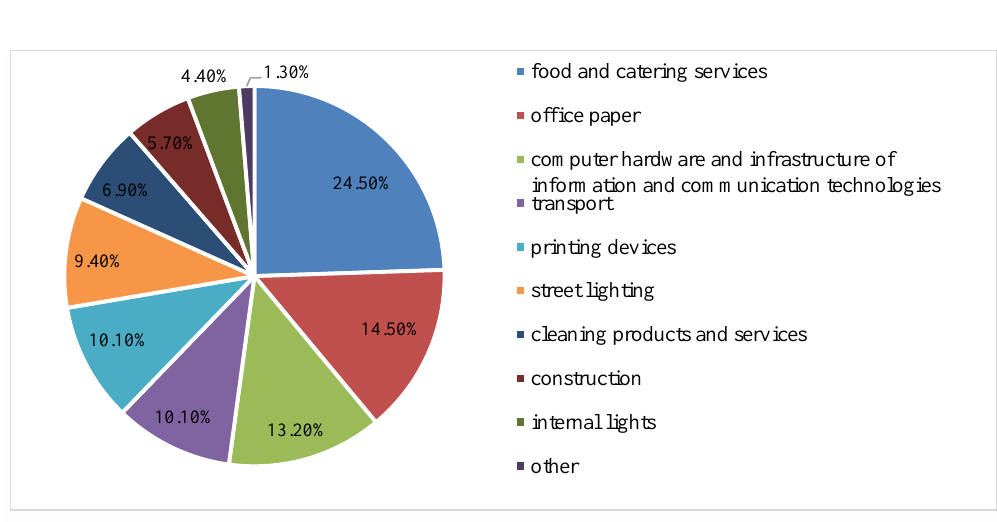
Fig. 4. GPP goods and service groups in Latvian municipalities (developed by the author based on the data from the